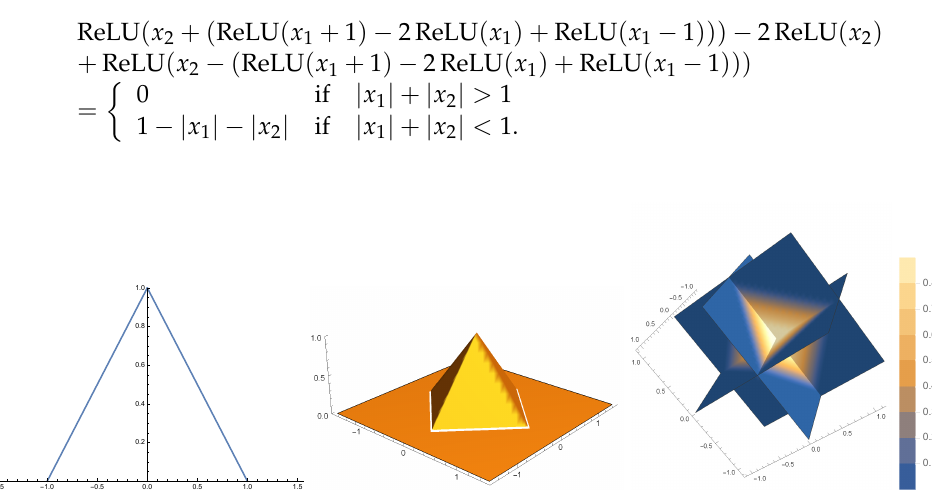
Figure 1. g ( x ) Left: 1-dimension Center: 2-dimension Right: 3-dimension with range. In